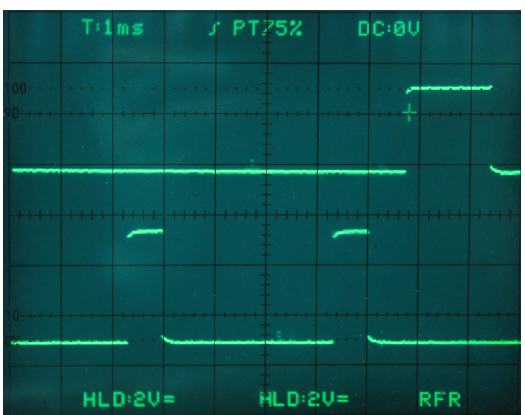
Figure 9. The lower trace shows the last data acquisition operation in Figure 8 (first pulse on the left) in a sequence of ten, the upper one shows the time spent sending a packet on the